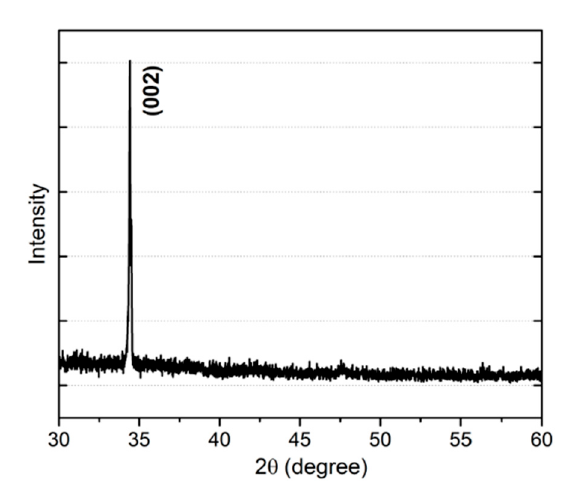
Figure 3. XRD spectra of ZnO NRs grown on a sputtered/annealed (300 °C)